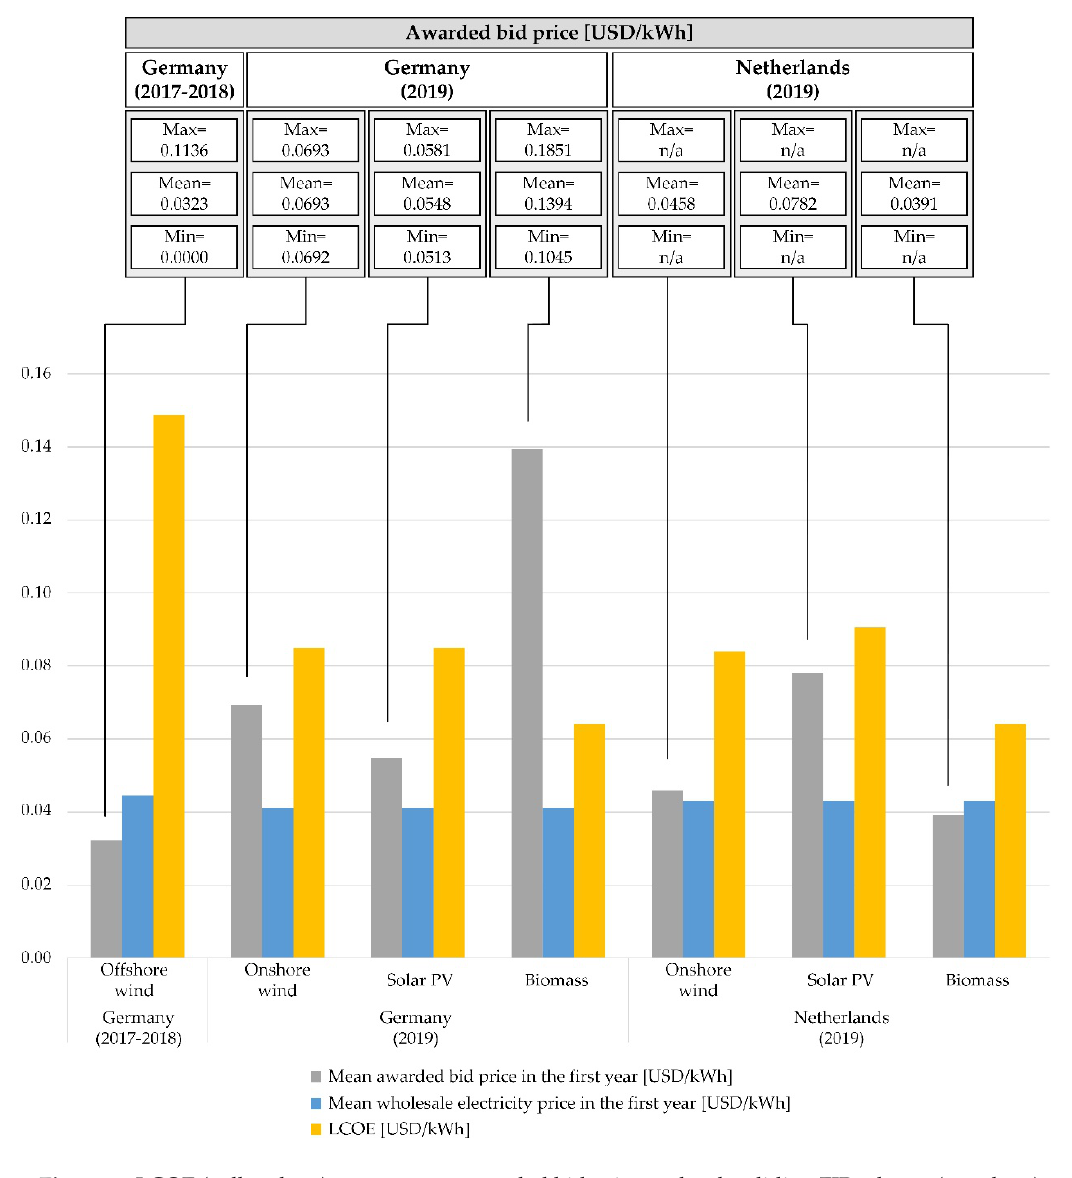
Figure 3. LCOE (yellow bars) versus mean awarded bid price under the sliding FIP scheme (grey bars) and mean wholesale electricity price in the first year (blue bars) for the auctions from Germany and the Netherlands listed in Table 1. Source: self ‐elaboration. Table 4. Project and equity NPV and IRR for the German biomass and the Danish solar PV and onshore wind auctions under the base case assumptions in Table 3. Source: self ‐elaboration.